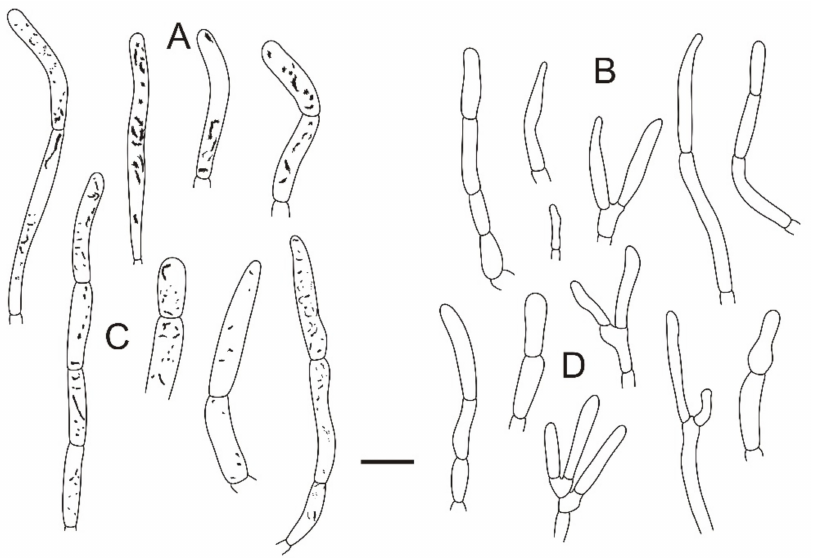
Figure 21. Microscopic features of Russula subversatilis (BJTC C653). ( A ) Pileocystidia near the pileus margin. ( B ) Hyphal terminations near the pileus margin. ( C ) Pileocystidia near the pileus center. ( D ) Hyphal terminations near the pileus center. Scale bar: 10 µ m.